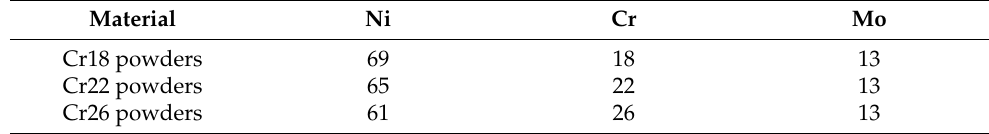
Table 1. Chemical compositions of three Ni-Cr-Mo alloy powders in wt.%.